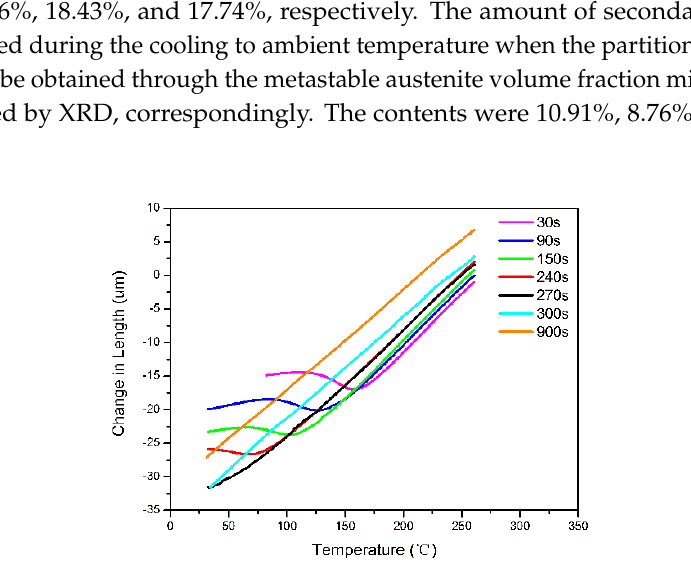
Figure 5. Change in length of different partitioning times during final cooling.